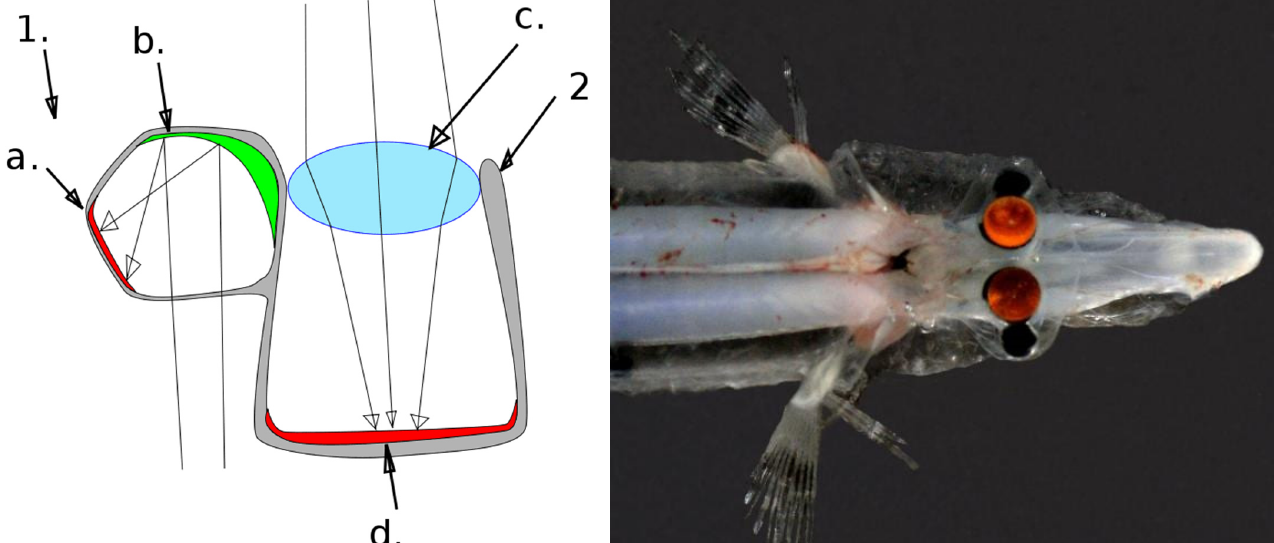
Figure 5. The downward-facing eye of the brownsnout spookfish (1) centers light on the retina ( a ) using reflective crystals ( b ). The main eye (2) uses a lens ( c ) and center light on the retina ( d ) (Left). The brownsnout spookfish’s additional eye structures let the fish see below. (Credit: Florida Atlantic University (Right, (Source: https://asknature.org/strategy/extra- eyes-direct-light/).